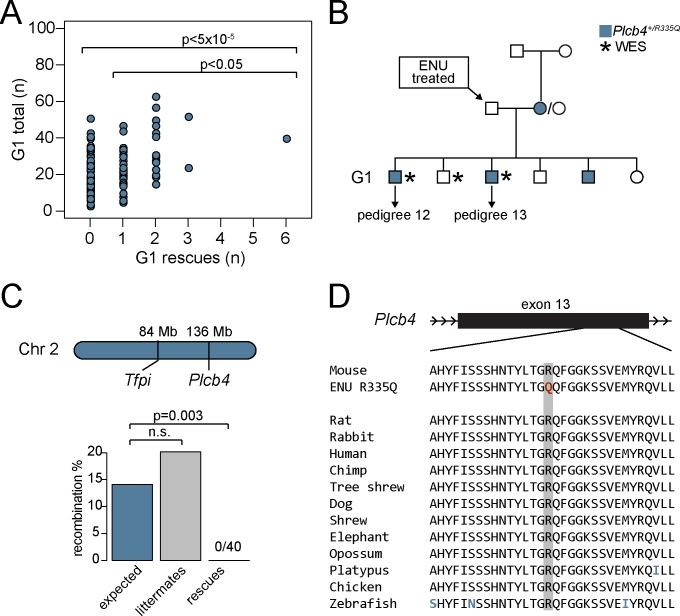
Plcb4R335Q co-segregates with the rescue phenotype in pedigrees 12 and 13.A) One ENU mating exhibited a significantly higher number of rescue progeny (n = 6) compared to all ENU matings (p<5x10-5) and compared to ENU matings with ≥1 rescue progeny (p<0.05). B) One female in this ENU mating carried a de novo SNV (R335Q) in the Plcb4 gene that was inherited in phase with the Tfpi- allele by 3 of the G1 rescues. C) The Plcb4 gene is loosely linked to the Tfpi locus on chromosome 2, with a predicted recombination rate of 14.1%. No recombination was observed in 40 rescues from pedigree 12 and 13, while their littermates (n = 149) exhibited close to the expected recombination rate. D) The Plcb4R335Q mutation lies in a highly conserved region in exon 13 (data from Multiz alignment on UCSC Genome Browser).